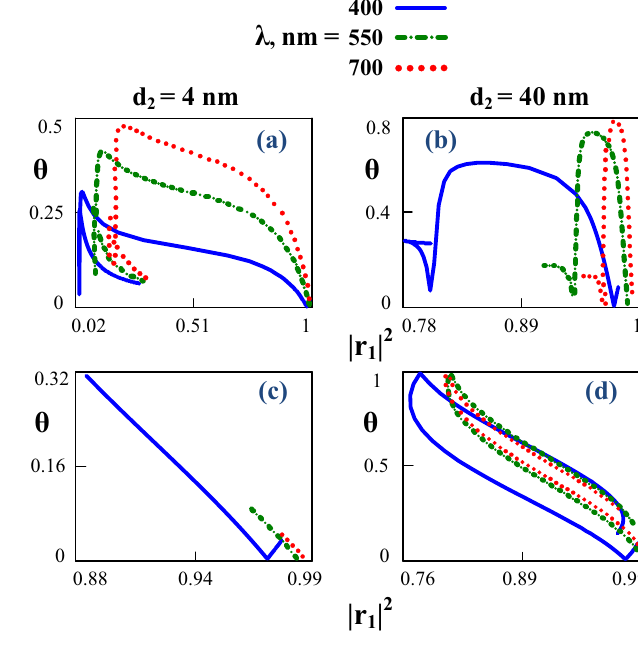
Fig. 9. Pairs of values (| r 1 | 2 , u ) realized under changing parameters e 0 b (a, b, according to the data in Fig. 4a, c, f, h) and e 0 2 (c, d, according to the data in Fig. 7a, c, d, f) for the different wavelengths of the incident wave. The values of parameters are: d 2 =4nm (a, c), 40nm (b, d), e 00 b ¼ 0 : 1 , m b = 1 (a, b), e 00 2 ¼ 0 : 1 , m 2 =1 (c, d), for all the graphs c =0, d 1,3,4 =0. Fig. 8. Dependences of angle u (a, d), PSD of the re fl ected waves (b, e) and corresponding energy re fl ection coef fi cients (c, f) on parameter e 0 2 for various PCMs (amorphous and crystalline GST 225, VO 2 ) as the substrate material. The values of parameters are: d 2 = 5nm (a – c), 50 nm (d – f). The values of parameters for all the graphs are: c =0, d 1,3,4 =0, l =650 nm, e 00 2 ¼ 0 : 2 , m 2 = 1. The horizontal lines in fi g. f characterize energy re fl ection coef fi cients for the substrates corresponding to the data in c, f. The black horizontal dashed line in fi gs. b, e corresponds to the condition D ’ =0. Parameter e 0 2 is used as the abscissa axis for all the graphs.